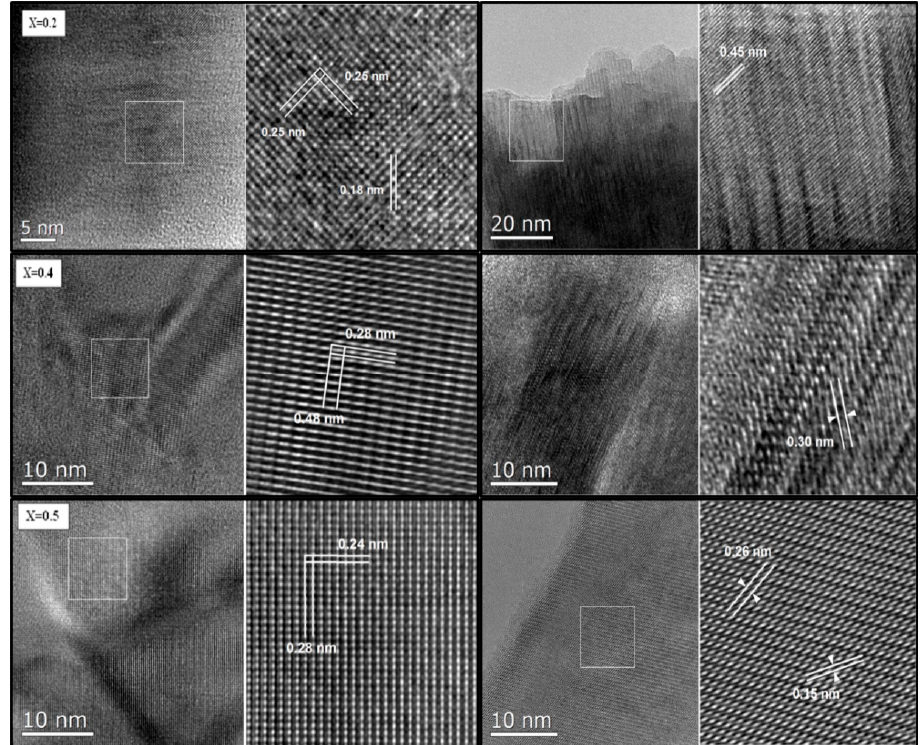
Figure 3. High-resolution transmission electron microscope (HRTEM) images of prepared Sr 1 − x Mn x Fe 12 − x Y x O 19 (x = 0.2, 0.4, and 0.5) nanohexaferrites.